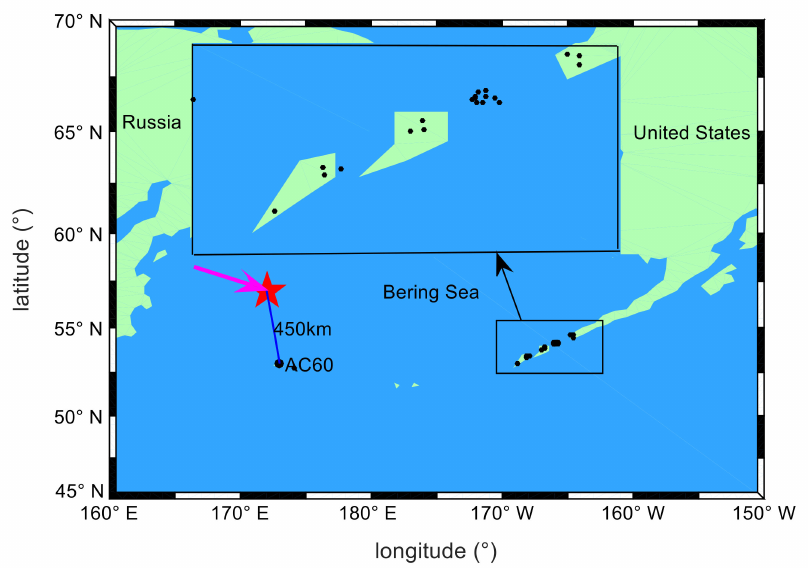
Figure 1. The distribution of the Bering Sea meteor explosion point (red pentagram) and GPS sites (black dots). The purple line with the arrow indicates the trajectory of the meteor movement. The black rectangle is an enlarged view of the distribution of some GPS